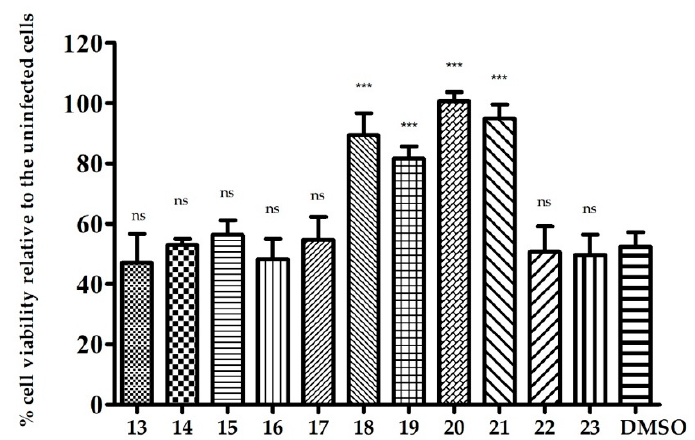
Figure 2. The effect of uridine glycoconjugates on tick-borne encephalitis virus (TBEV)-induced cytopathic effect. A549-infected cells (TBEV Hypr strain (multiplicity of infection (MOI) of 0.1)) were treated with 25 μ M of tested compounds or DMSO. After 48 h, the cell death was measured and calculated as the percentage of the cell viability. Error bars represent standard deviations from 3 separate experiments. ns: not significant; ***: p < 0.001 compared to infected DMSO-treated cells by one-way ANOVA with Dunnett’s post-test.